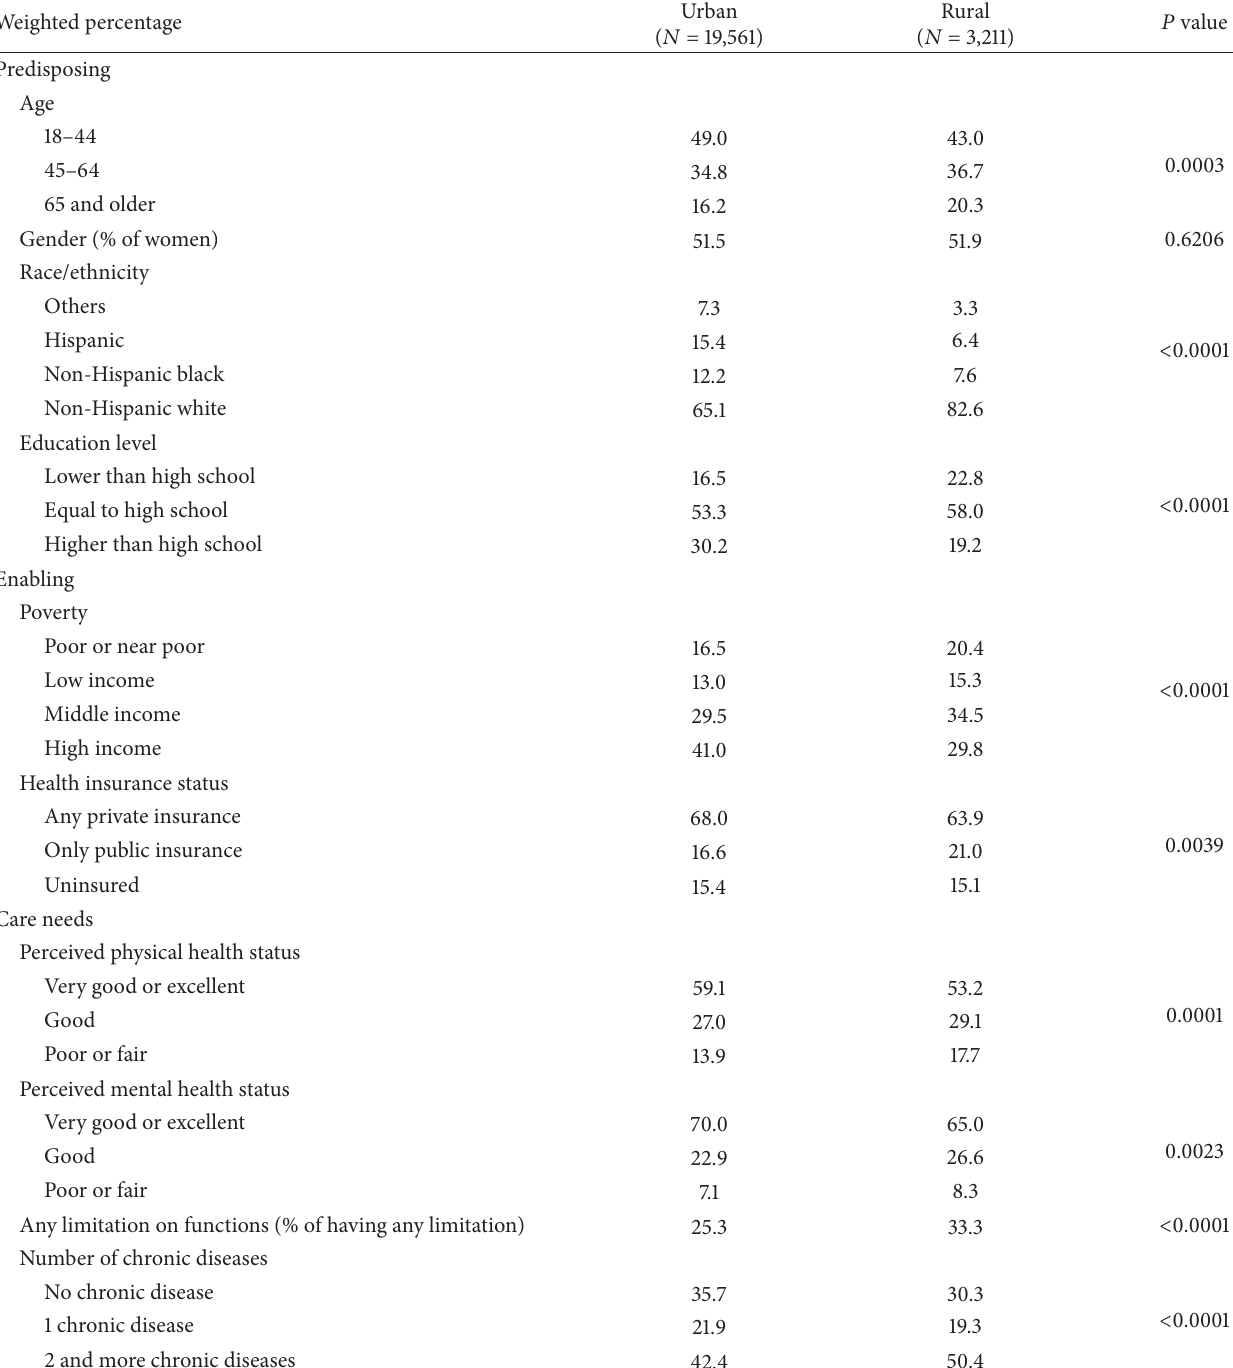
Table 2: Weighted description of personal characteristics by residence, MEPS